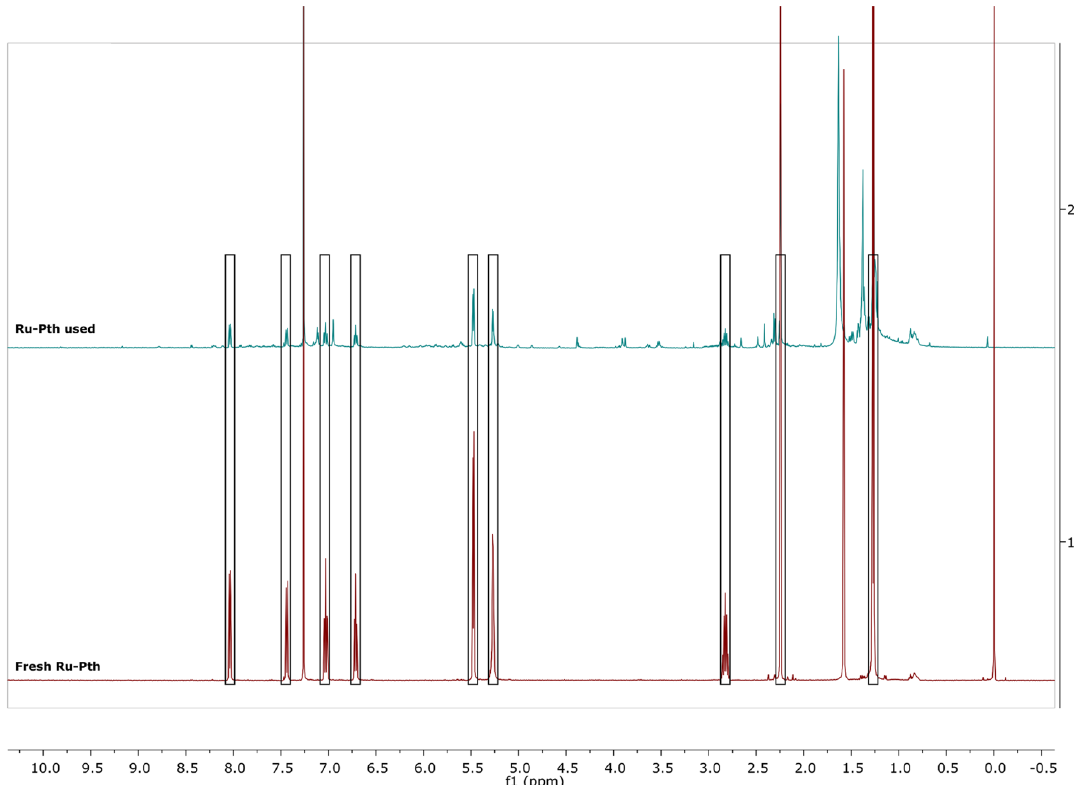
Figure 12. 1 H NMR spectra in CDCl 3 of the initial Ru-Pth complex before photocatalysis (fresh Ru-Pth) and after (Ru-Pth used) under optimized conditions (catalyst: styrene (1:100); styrene : H 2 O 2 (1:1); time: 3 h; solvent: acetonitrile; temperature: 70 °C. The additional peaks in the spectrum of Ru-Pth used occur as the crude reaction mixture after photocatalysis was